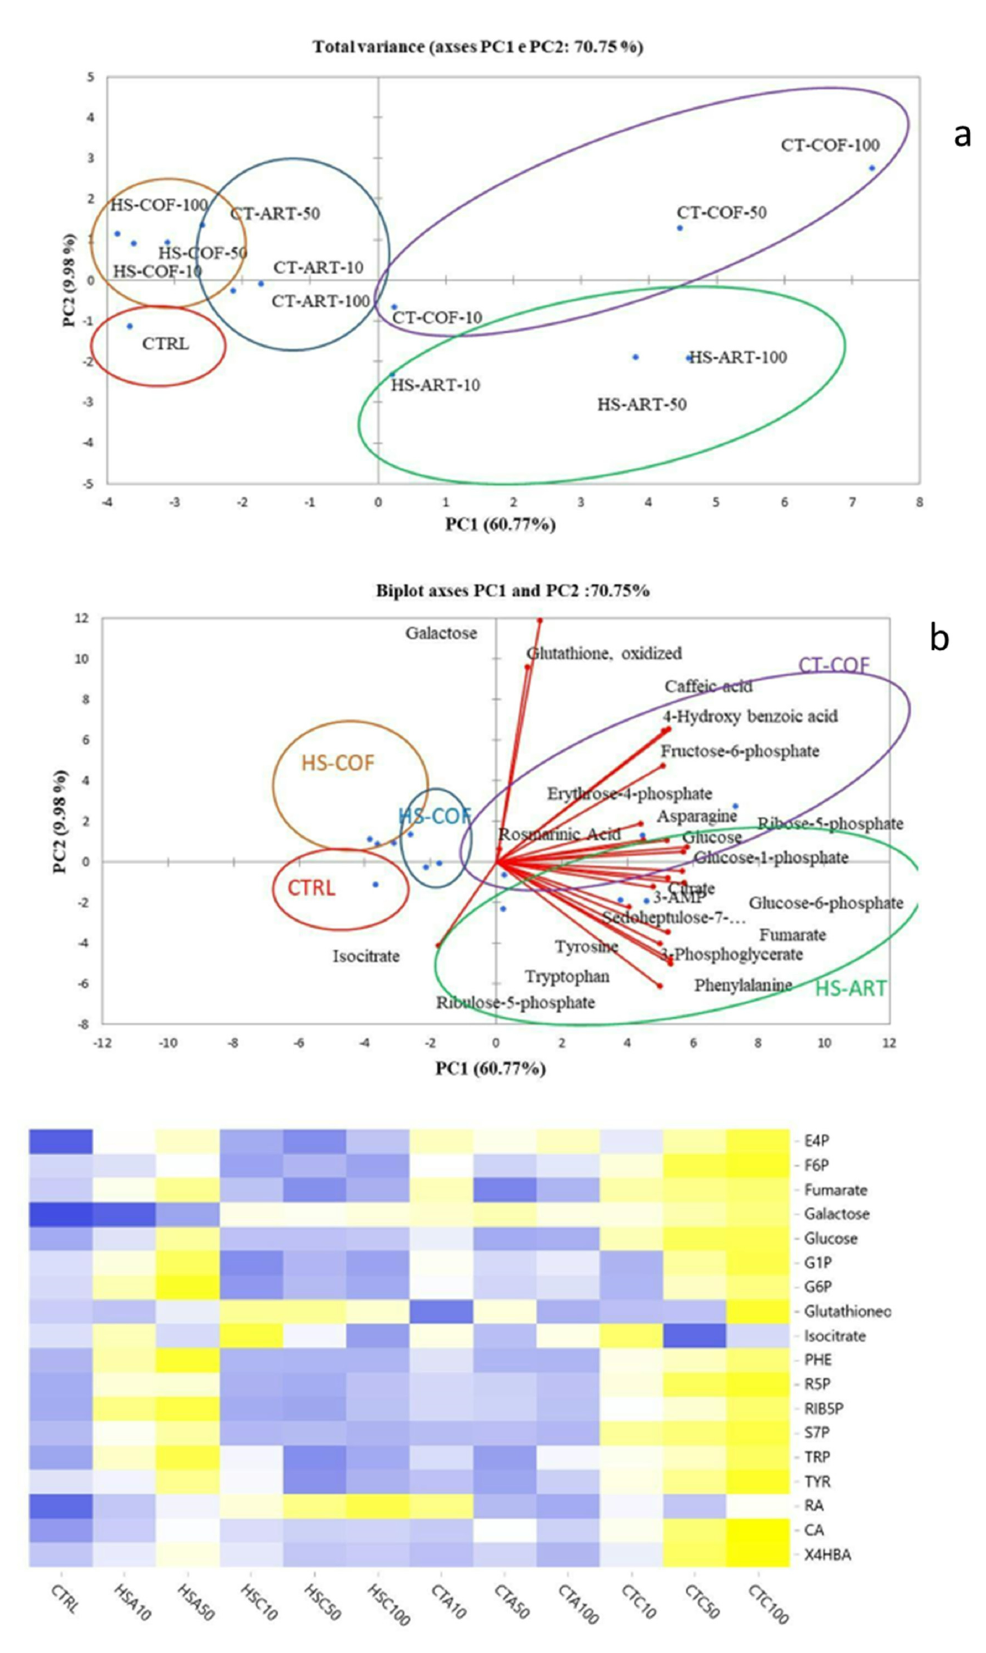
Figure 5. PCA biplot based on metabolites identified by targeted LC-HRMS in the apolar fraction of leaves extracts from basil plants treated with different organic extracts ( a ). Heatmap prepared